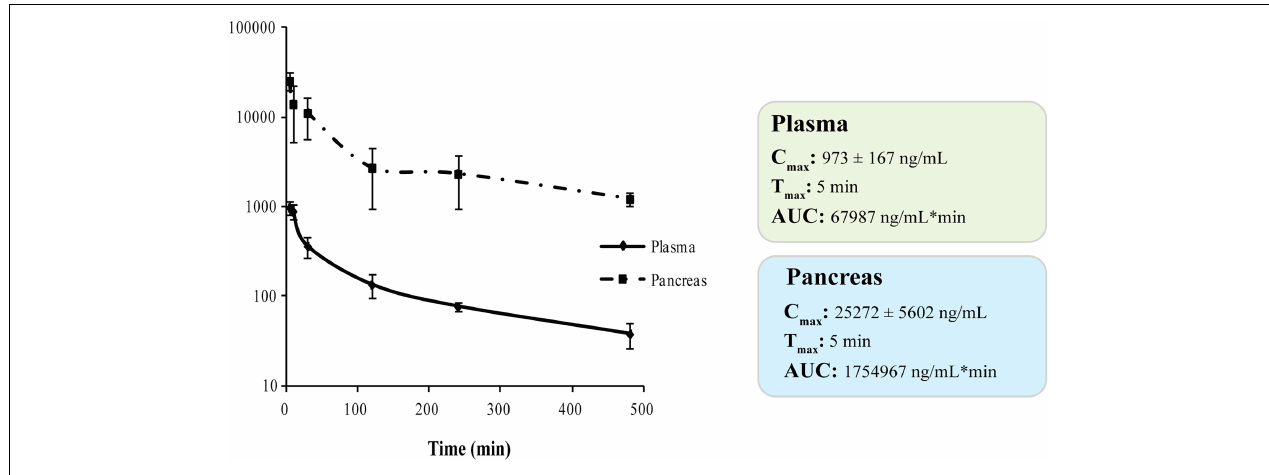
FIGURE 6 | Plasma and pancreas PK parameters of RC-106 after i.p., administration at 10 mg/kg.